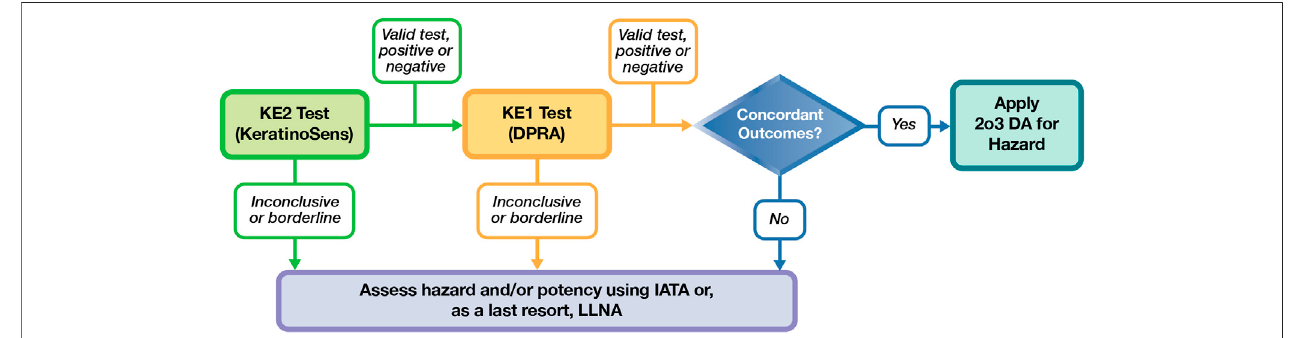
FIGURE 1 | Proposed framework for a non-animal assessment of skin sensitization potential of agrochemical